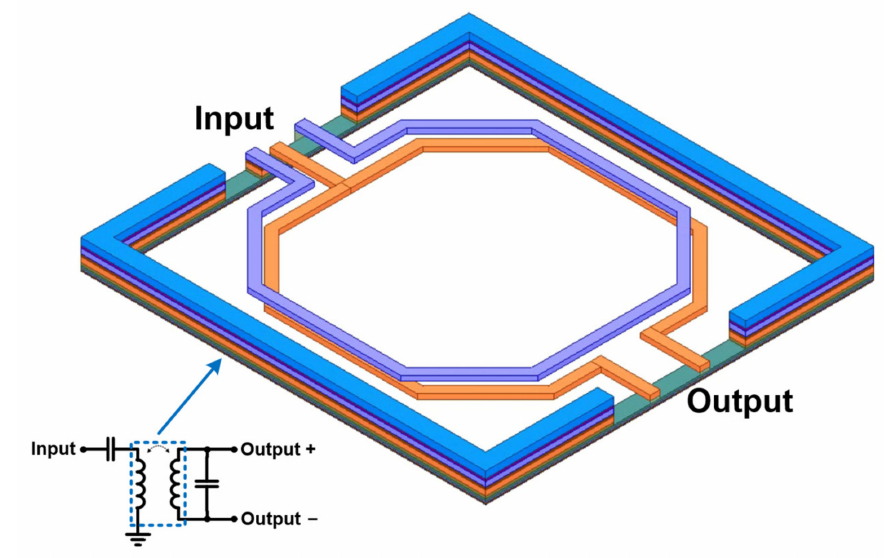
Figure 10. 3D EM model of a passive balun.